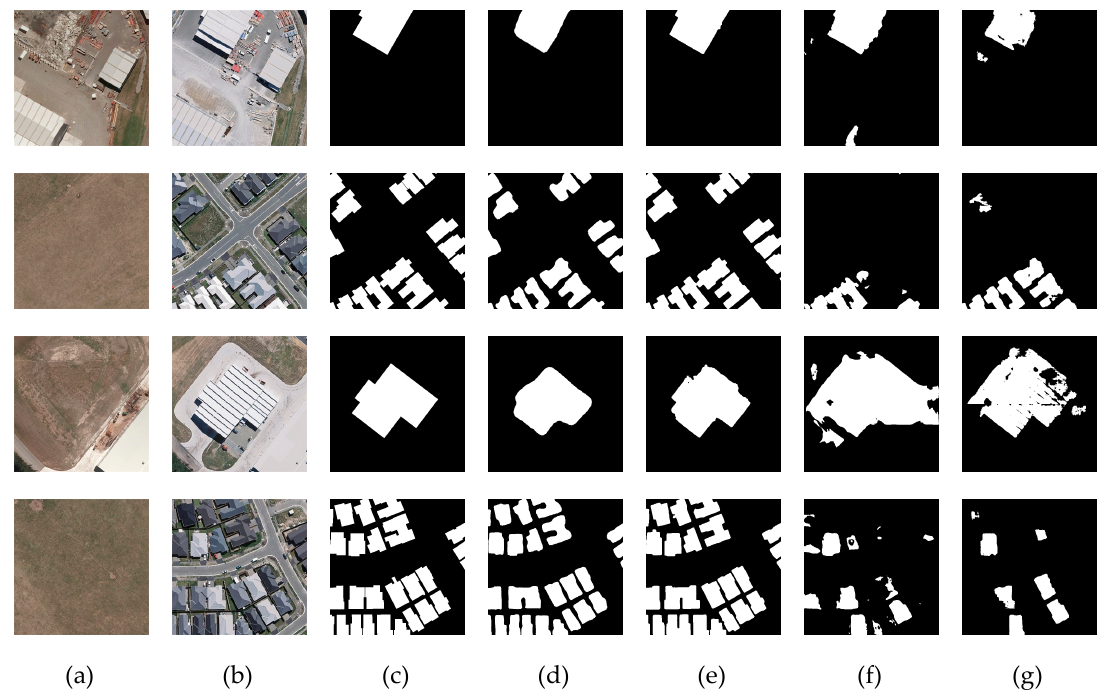
Figure 11. Comparison of change detection methods with half of the training samples. ( a ) Image 2011. ( b ) Image 2016. ( c ) Label. ( d ) Our method with the Mask R-CNN building extraction. ( e ) Our method with the MS-FCN building extraction. (f) FC-EF. ( g ) GAN-based change detection.